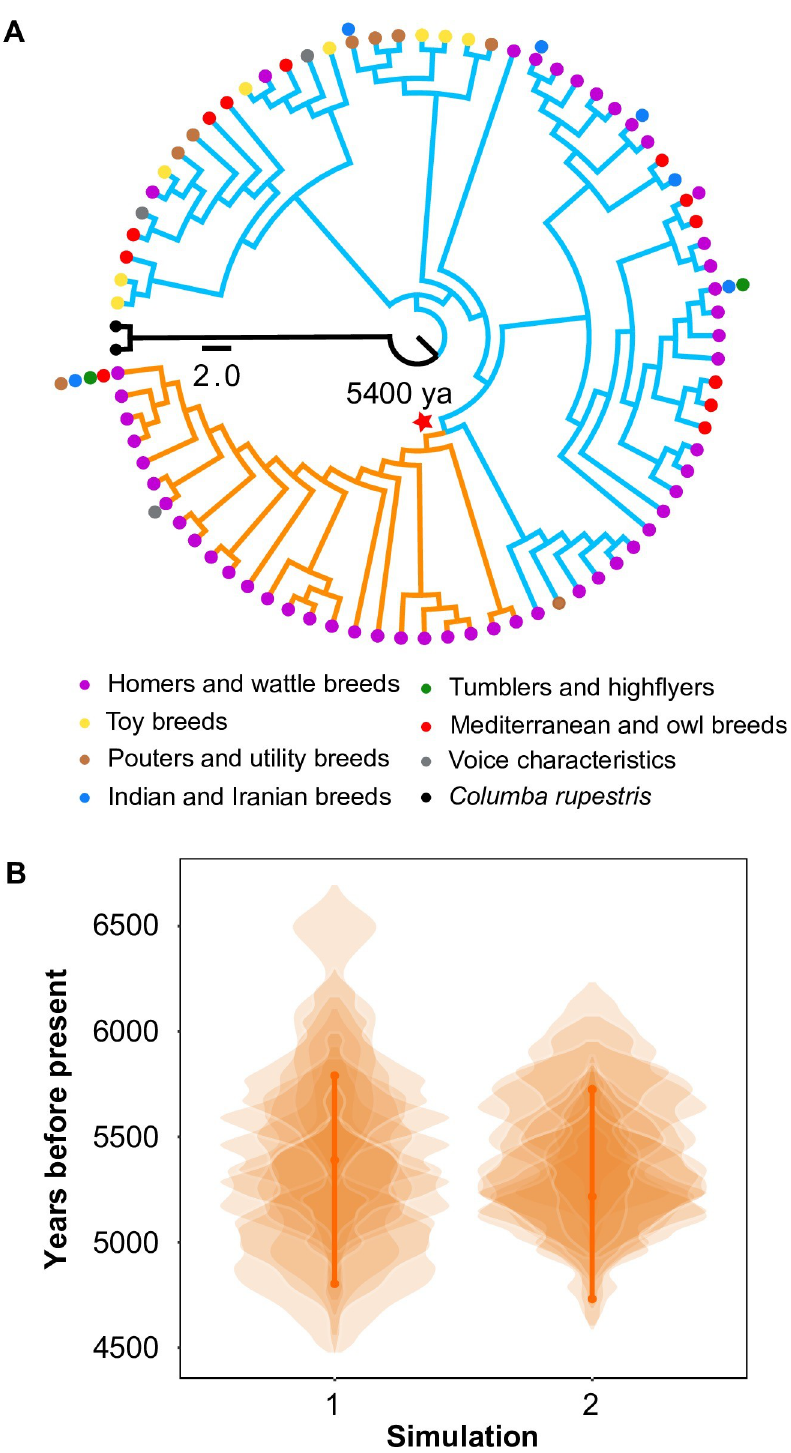
Fig 5. The origin of the pearl iris variant tr mut in domestic pigeons. (A) Neighbor-joining (NJ) trees of the 9 kb nonrecombining Tr region based on 81 haplotypes from 140 unrelated individuals comprising 139 domestic pigeons (35 fancy pigeons, two feral pigeons, and 102 racing pigeons) and one Columba rupestris (outgroup). All nodes had more than 60% support from 1,000 bootstrap replicates. Orange branches indicate tr mut haplotypes, blue branches indicate Tr + haplotypes, and the black branch indicates the outgroup. Different circle colors represent the seven traditional breeds of domestic pigeons and the outgroup. The red star indicates the time of origin of the Tr